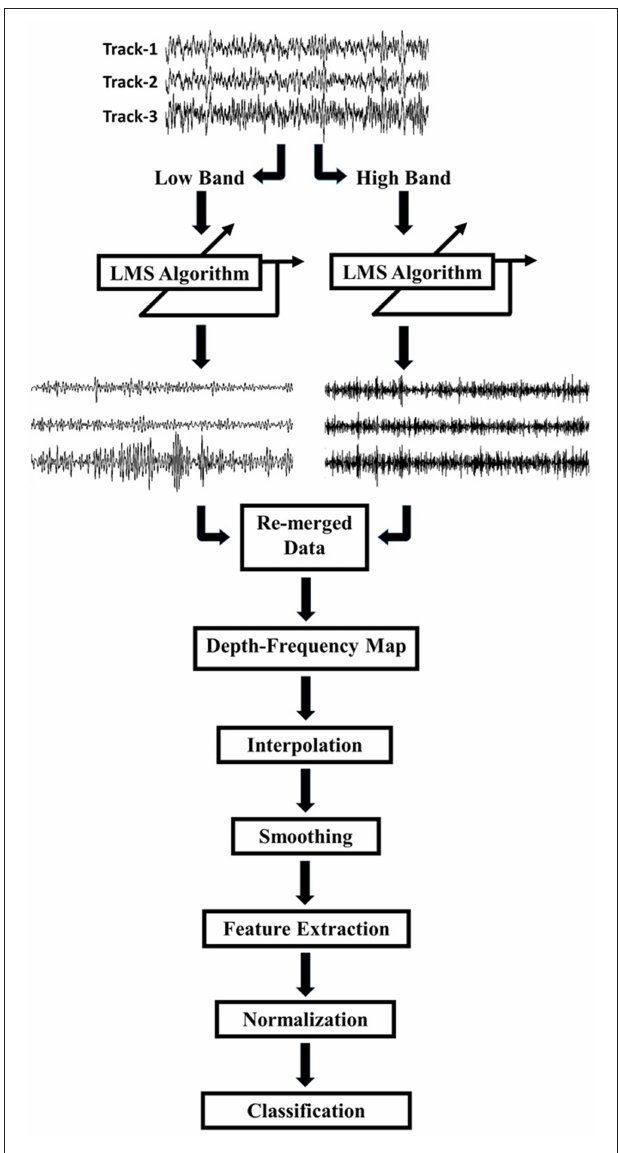
FIGURE 2 | Schematic of the work flow. LFPs recorded by 3 tracks of microelectrodes were decomposed into low (8–200Hz) and high (200–450Hz) frequency bands. Each track was de-correlated using LMS algorithm at each frequency band. De-correlated signals were combined and the frequency domain features were extracted for